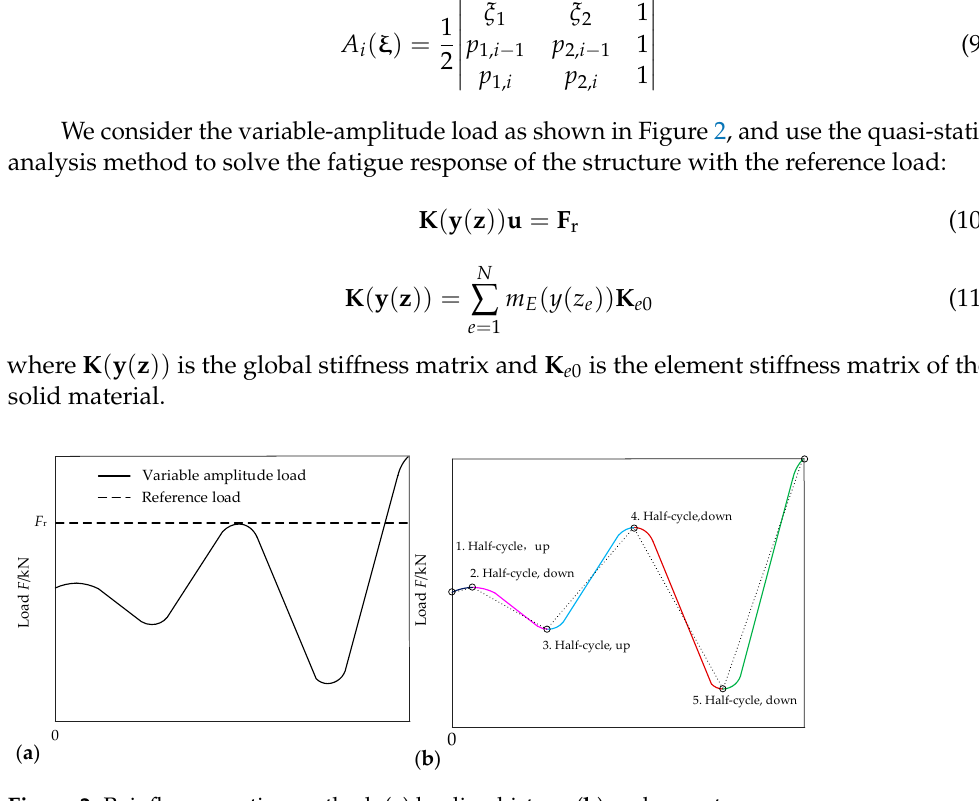
Figure 1. Polygon element definition: ( a ) define α i , ( b ) points arrangement.